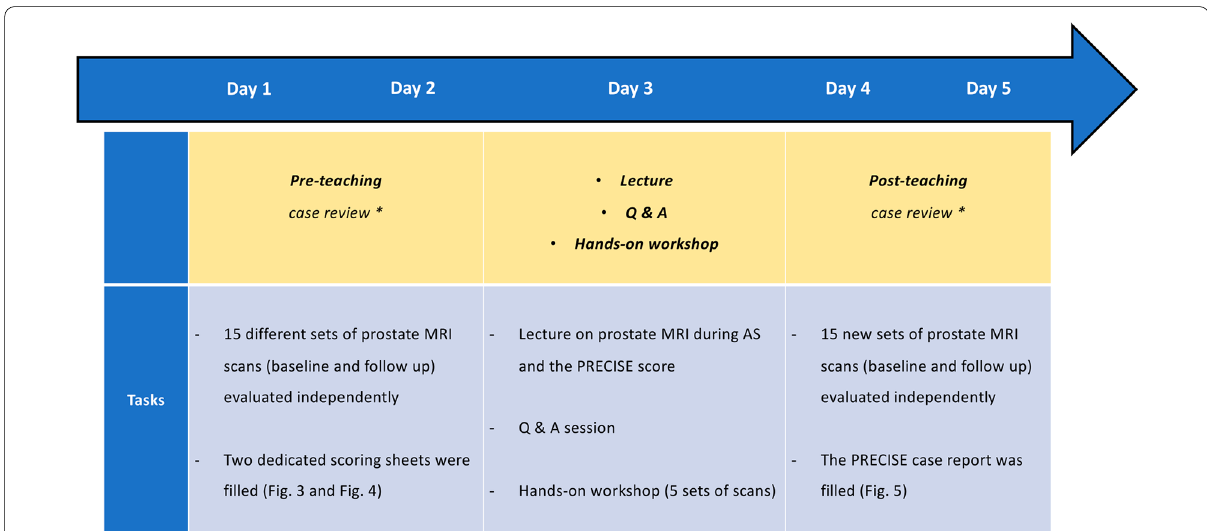
Fig. 2 Chronologic framework of the teaching fellowship. *Readers were given up to two weeks (before / after the lecture and workshop) to review the